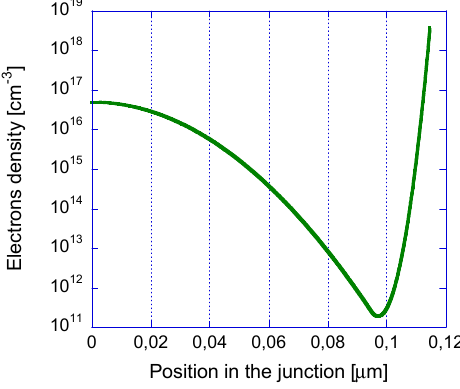
Figure 2. Electron density as a function of position in the